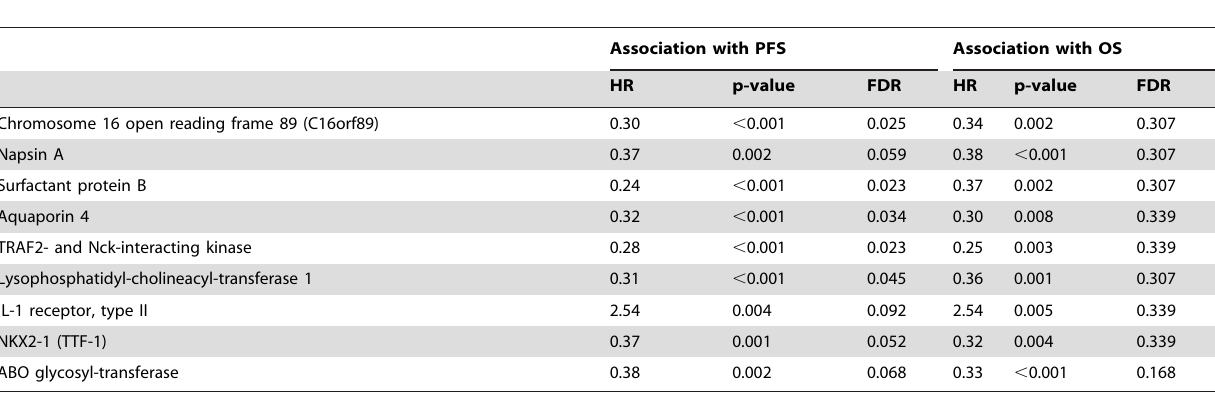
Table 2. Cox regression analyses of association between gene expression (high versus low expression; cutpoint: median) and PFS and OS (N =51 patients with